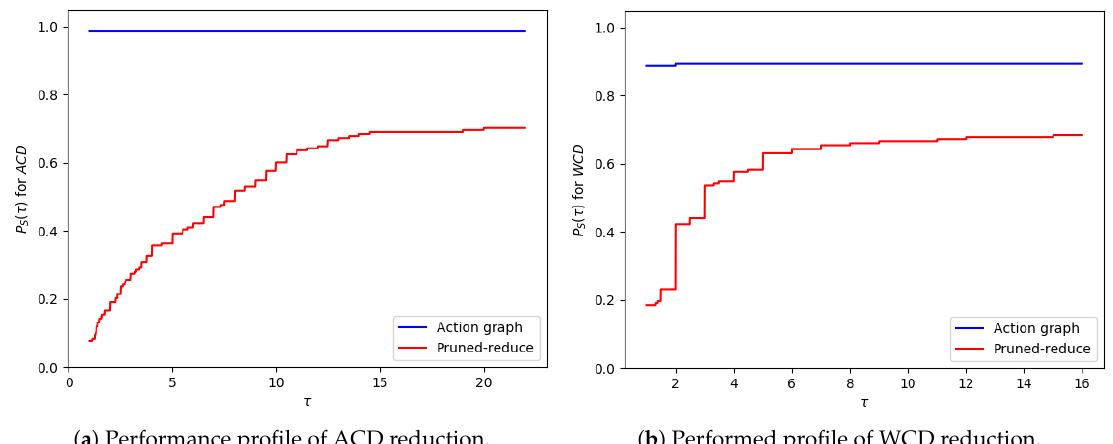
Figure 20. Results for comparing our Action Graph approach to pruned-reduce on all action removal